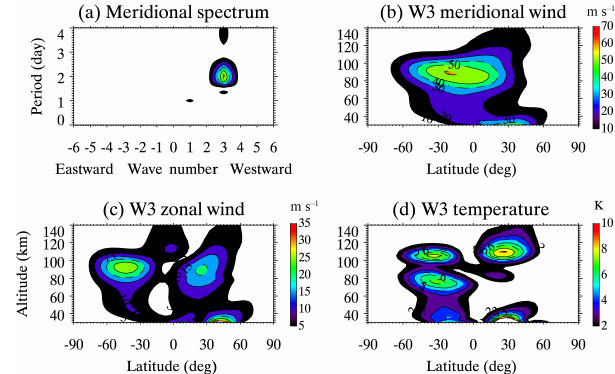
Figure 5. (a) The least-square fitting spectrum of the meridional wind at 22.5 ◦ S and ∼ 90km during model days 25–30 of case 1. A westward wave number 3 QTDW dominates the spectrum. The vertical and global structures of the W3 in meridional wind, zonal wind, and temperature are shown in (b) , (c) , and (d) , respectively. The contour intervals are 10ms − 1 , 5ms − 1 , and 1K for meridional wind, zonal wind, and temperature,